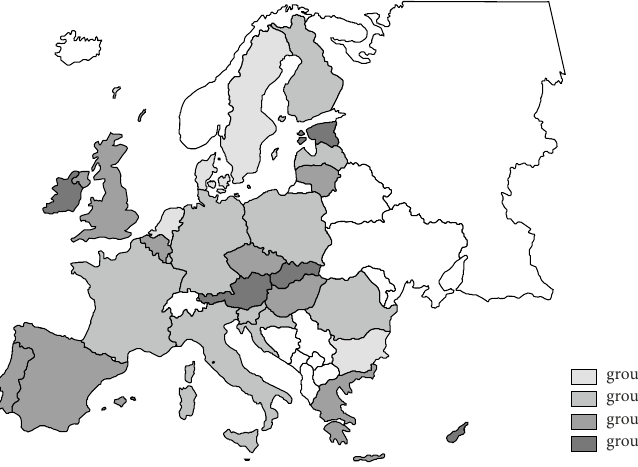
Figure 3. Spatial distribution of EU countries according to the level of sustainable development in 2009